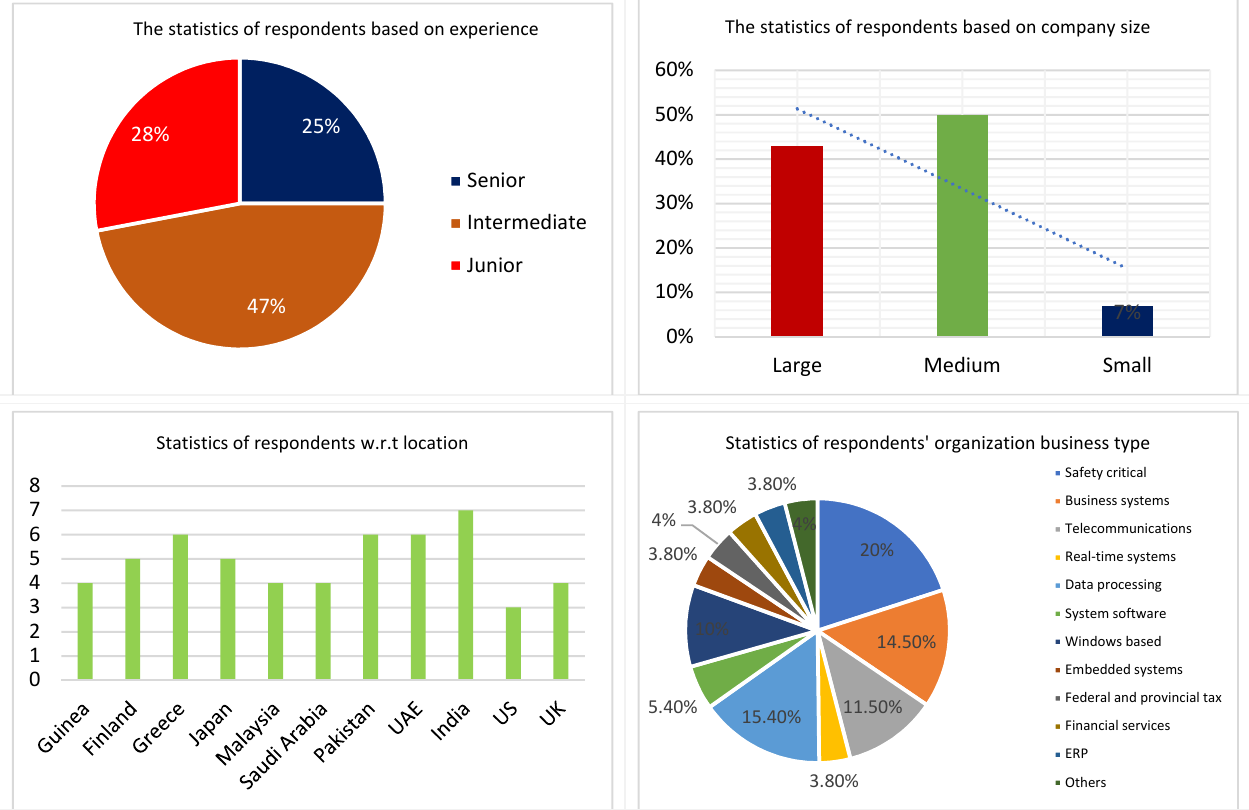
Figure 3. Details of respondents .